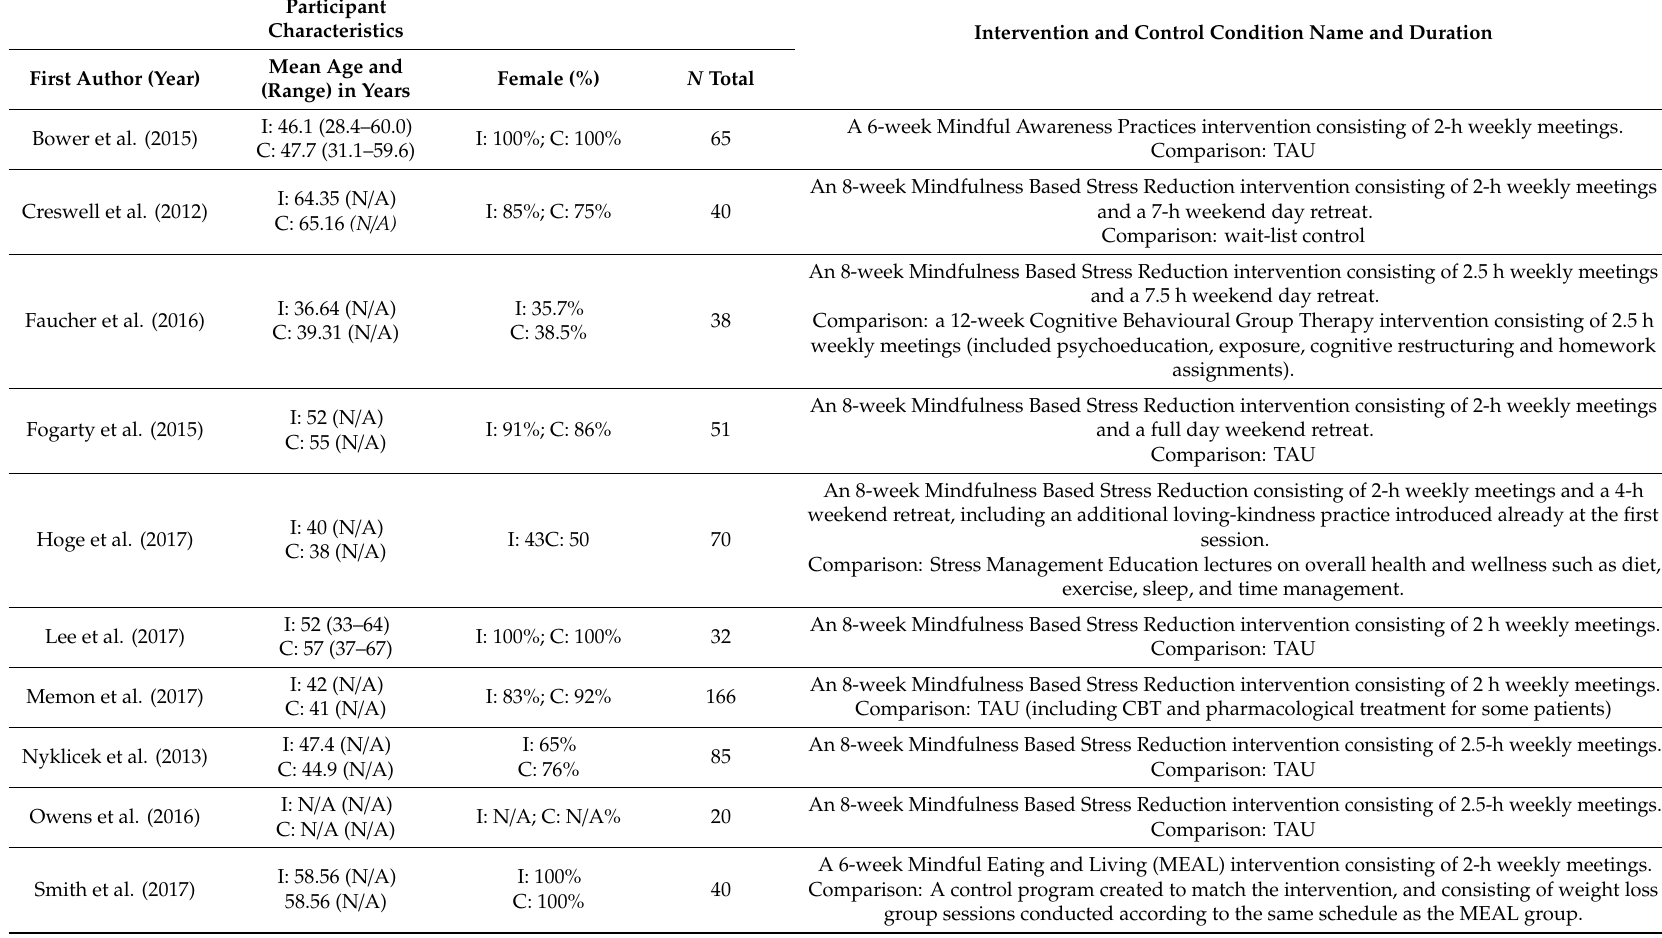
Table legend: I = intervention; C = control; N / A = data not available; treatment as usual (TAU); Cognitive Behavioural Therapy